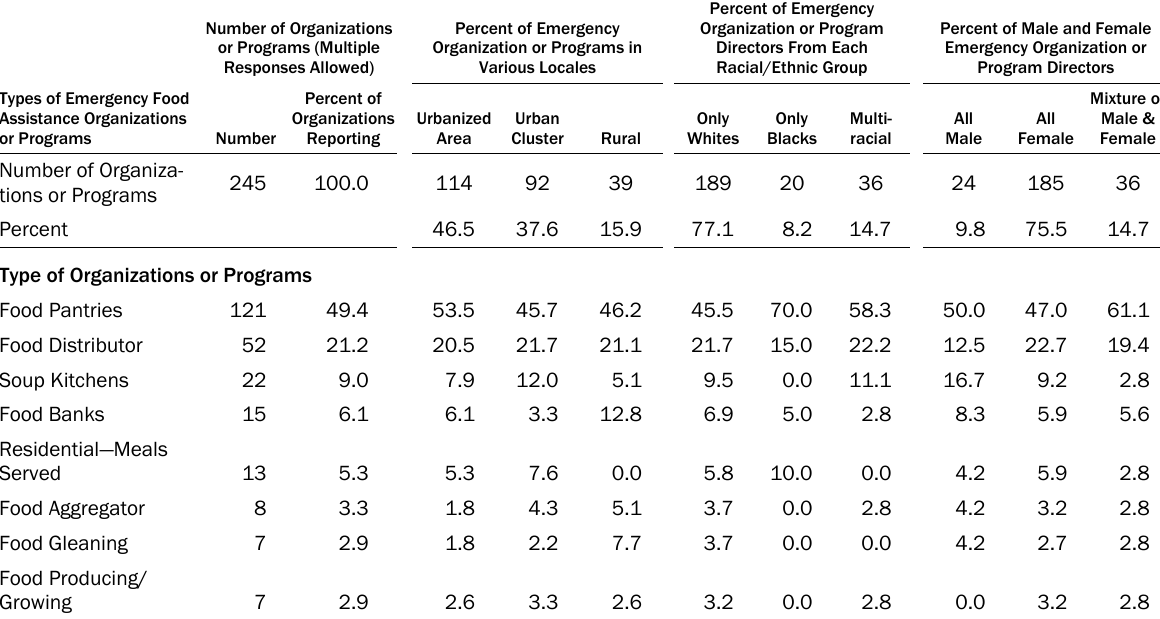
Table 3. Characteristics of Emergency Food Assistance Organizations